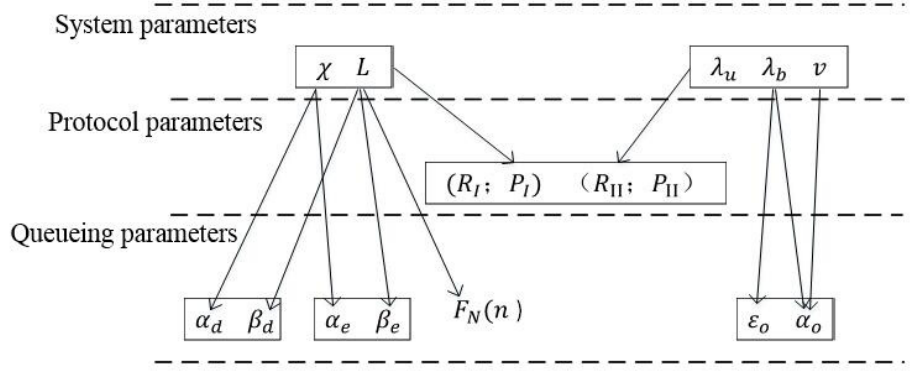
Figure 3. Relationships among system parameters, protocol parameters and queueing